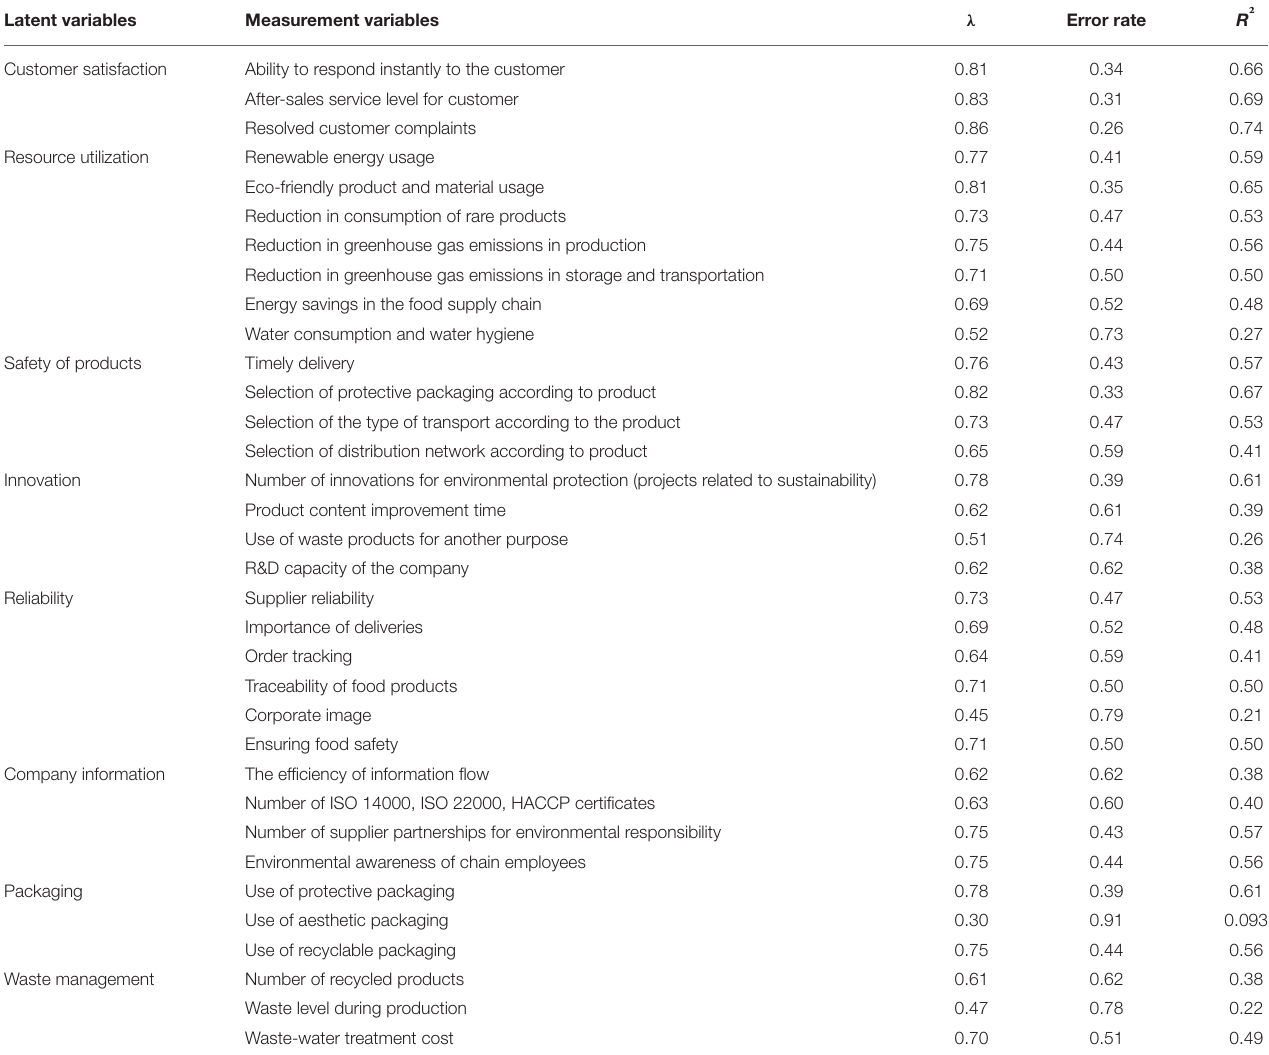
TABLE 5 | Standardized λ , error rate, and R ² values of the structural equation model. Latent